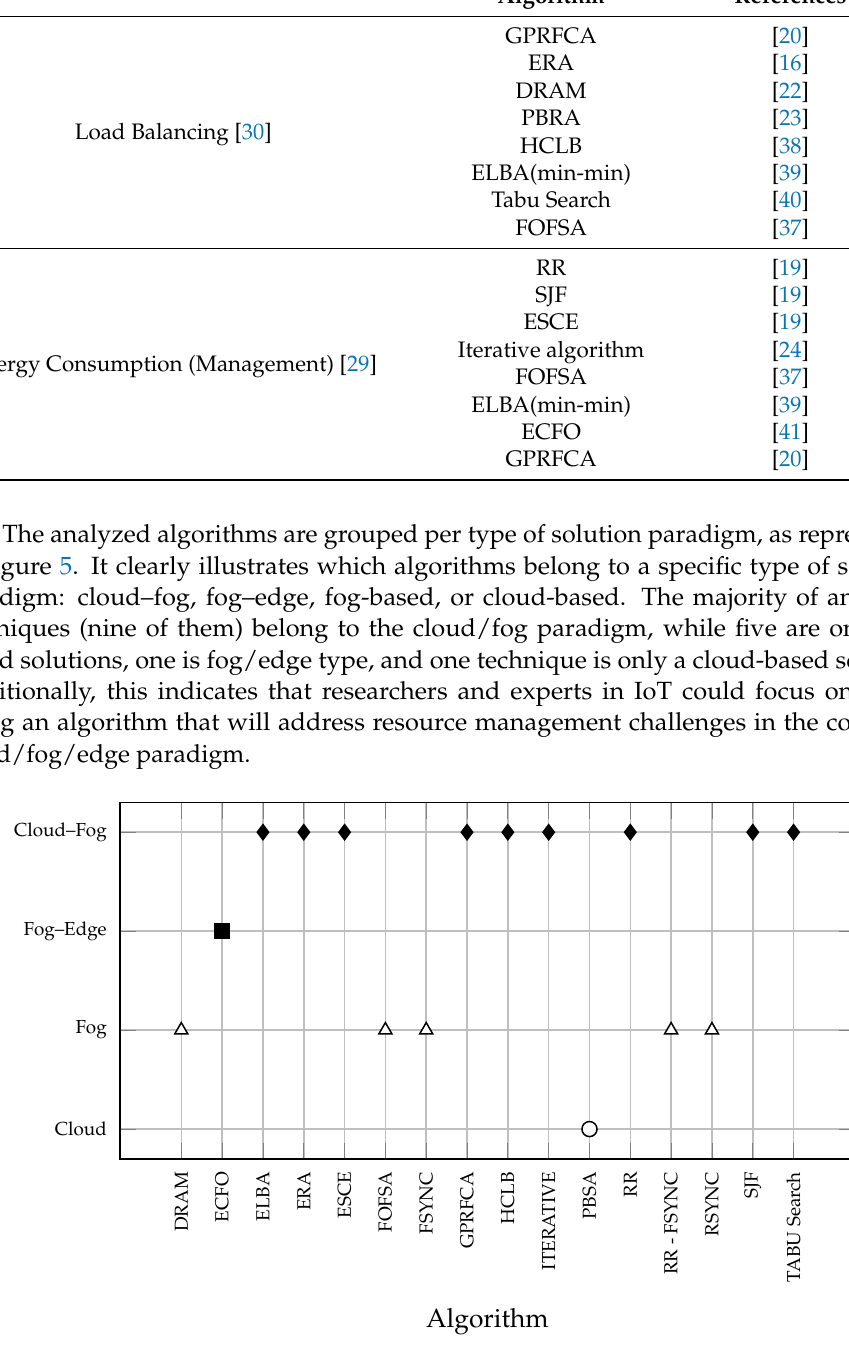
Figure 5. Reviewed algorithms per type of solution